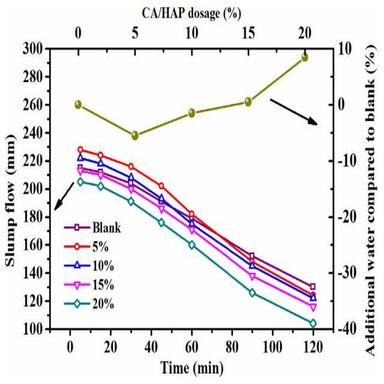
The fluidity of cement mortars with different dosage of CA/HAP. Fig. 9. Hydration heat of cement pastes with different dosage of CA/HAP.